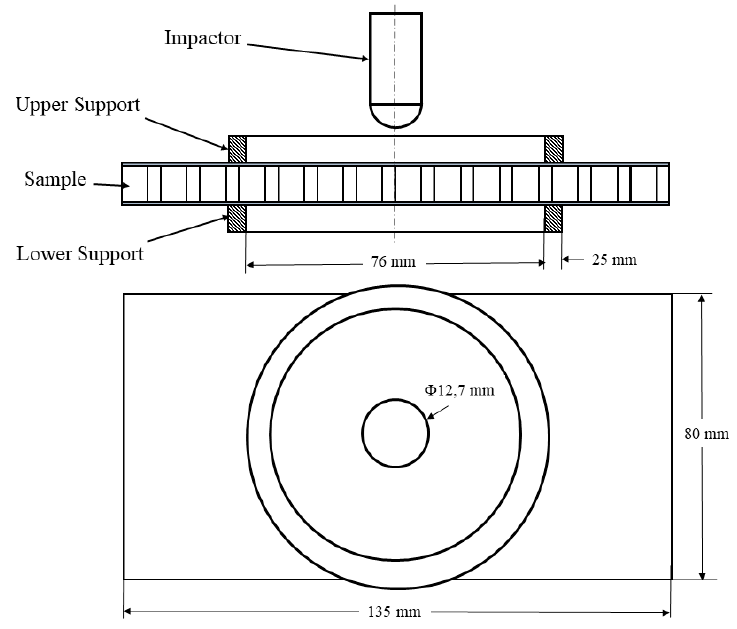
Figure 3. Low velocity impact test setup.